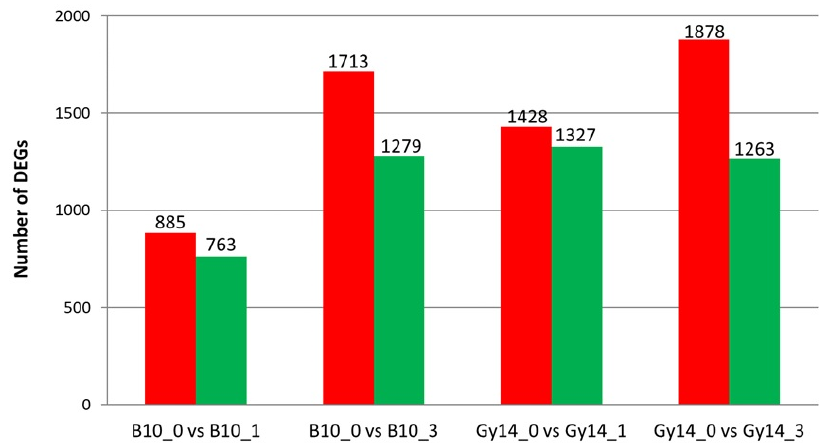
Figure 3. Summary of the differentially expressed genes (DEGs) identified for Gy14 and B10 lines at 1 and 3 dpi in comparison to 0 dpi. Numbers indicate DEGs detected in each pairwise comparison. Red color represents up-regulated genes, whereas green color corresponds to down-regulated genes. Abbreviations: B10_0 – B10 line at 0 dpi (control), B10_1 – B10 line at 1 dpi, B10_3 – B10 line at 3 dpi, Gy14_0 – Gy14 line at 0 dpi (control), Gy14_1 – Gy14 line at 1 dpi, Gy14_3 – Gy14 line at 3 dpi.